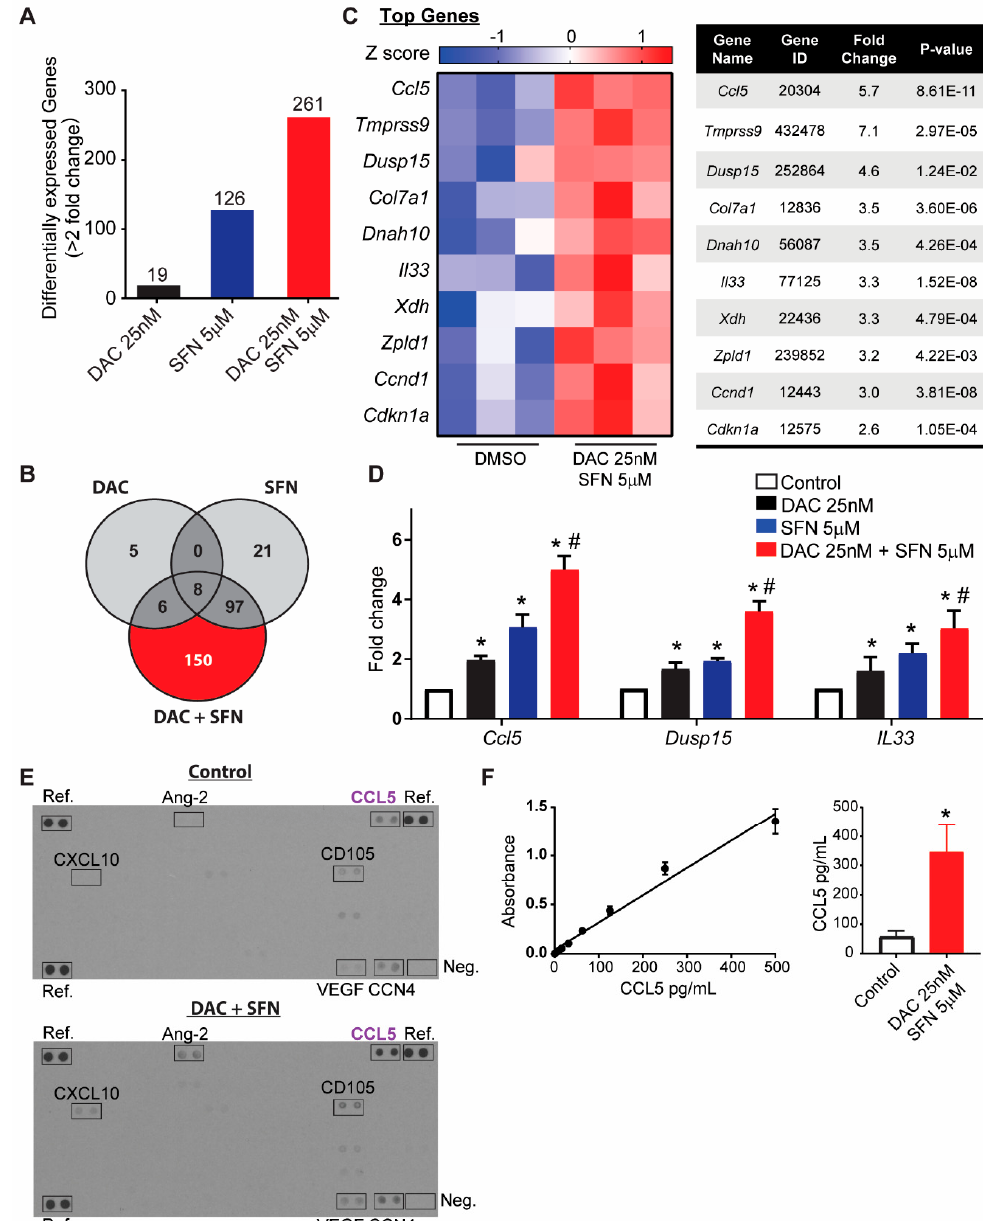
Figure 4. Validation of combination e ff ects from SFN and DAC. ( A ) The number of di ff erentially expressed genes induced by di ff erent treatments. ( B ) The number of unique genes responding to single and combination treatment. All genes were selected from greater than 2-fold change compared to control with p < 0.05. ( C ) A heatmap and list of top selected genes from SFN and DAC combination treatments (Z score shows in the color key). ( D ) Relative gene expression validation by rtPCR of Ccl5, Dusp15, and IL33 between treatments. * Significantly different from control, p < 0.05, # Single treatment is significantly different from combinational treatment, p < 0.05 (Student’s t -test). ( E ) Expression of cytokines detected by cytokine array. Ref indicates reference spots. Neg: negative control. Arrays were performed in duplicate. ( F ) Specific CCL5 ELISA further confirmed the increase in CCL 5 in DAC/SFN combination treatment. The left side indicated the standard curve of CCL5, ranged from 7.8 pg/mL to 500 pg/mL. The right side indicates the concentration of CCL5 in the supernatant is increased from 55pg / mL in control to 348 pg / mL in DAC / SFN combination treated group. All data were from two independent biological